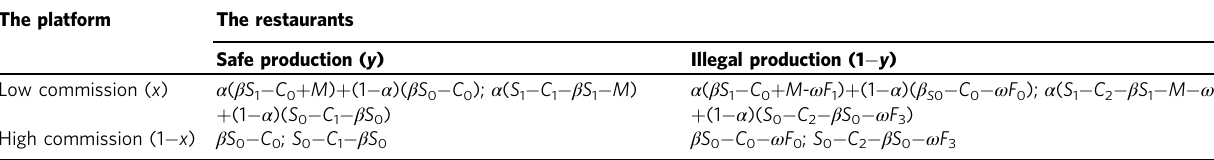
Table 1 The evolutionary game payoff matrix of the platform and